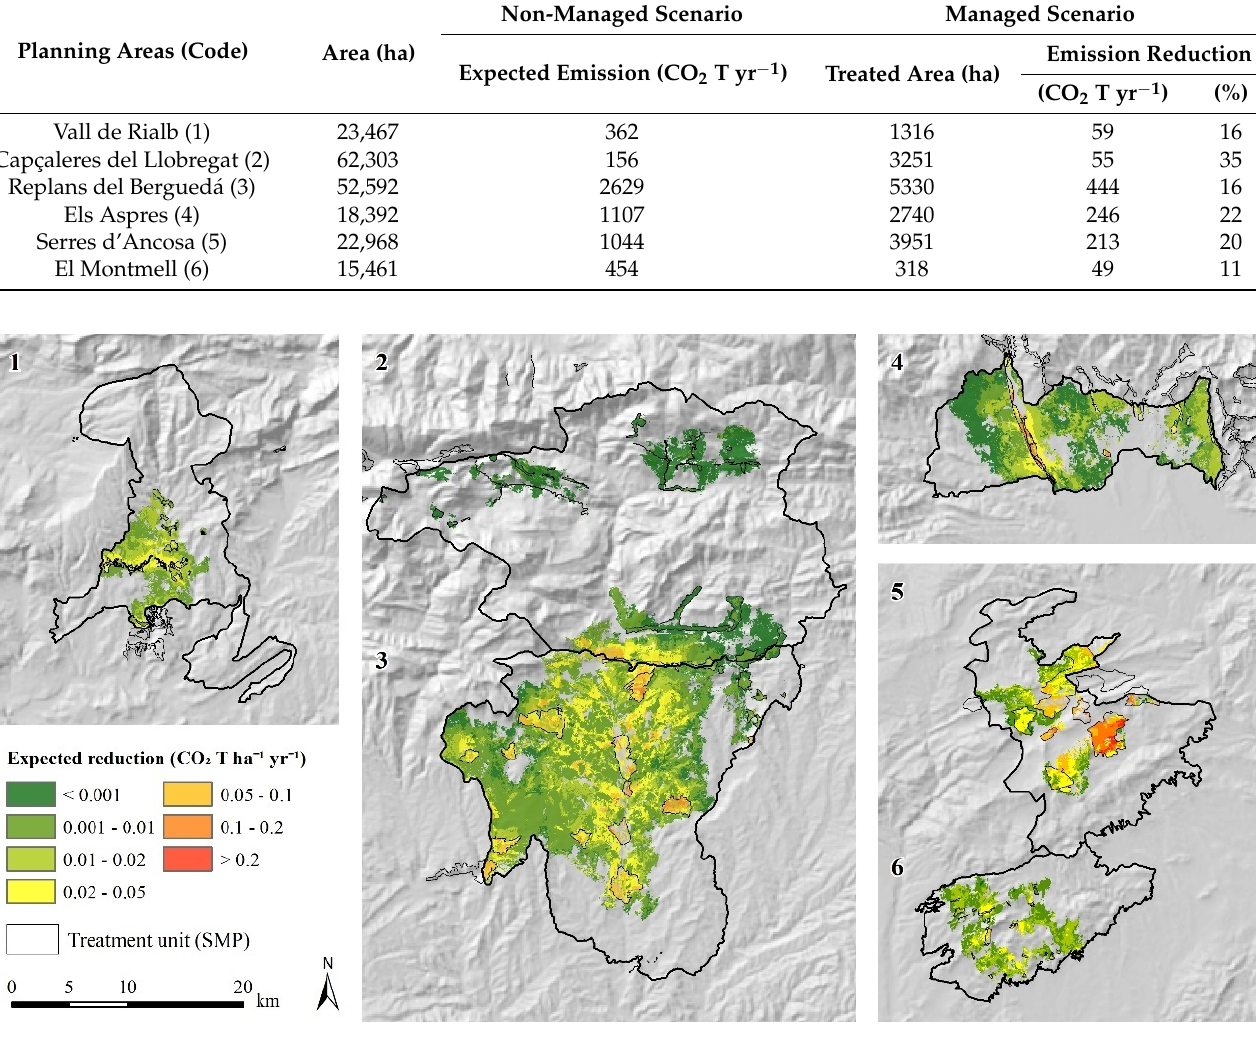
Table 3. Summary table with landscape-scale expected carbon dioxide emissions from wildfires and emission reductions after treatments. The emission reductions represent landscape-scale results accounting for the fuel treatment effects on treated SMPs (Figure 2) and neighboring lands (Figure 5).